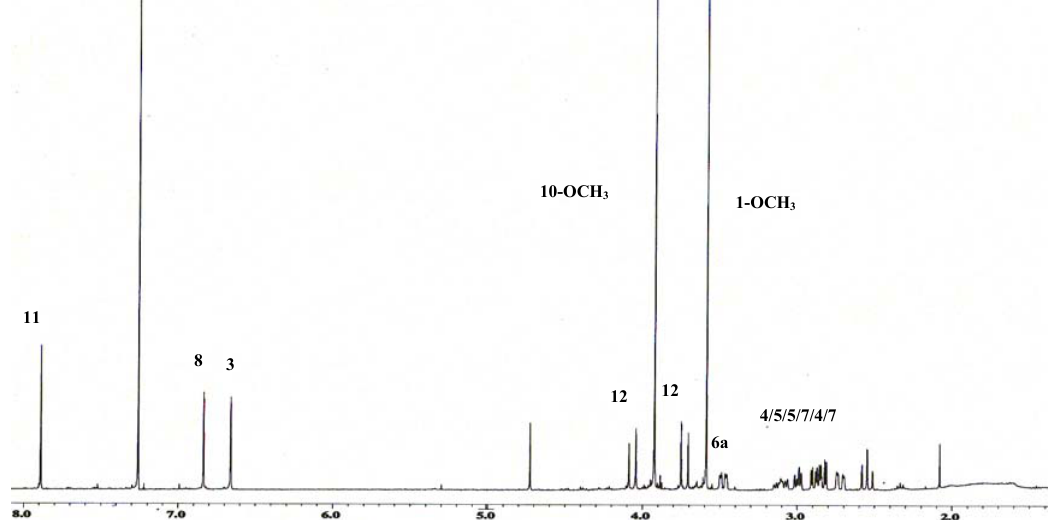
Figure 3. 1 H-NMR spectrum of alkaloid 1 .